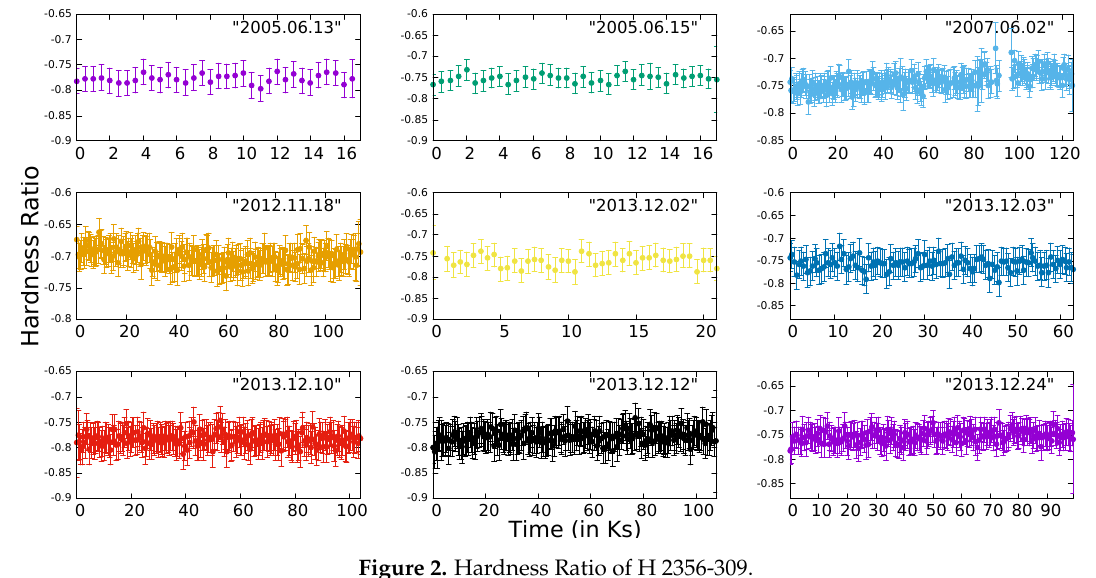
Figure 2. Hardness Ratio of H 2356-309. Table 3. Temporal Variation of hardness ratio (HR) of H-2356